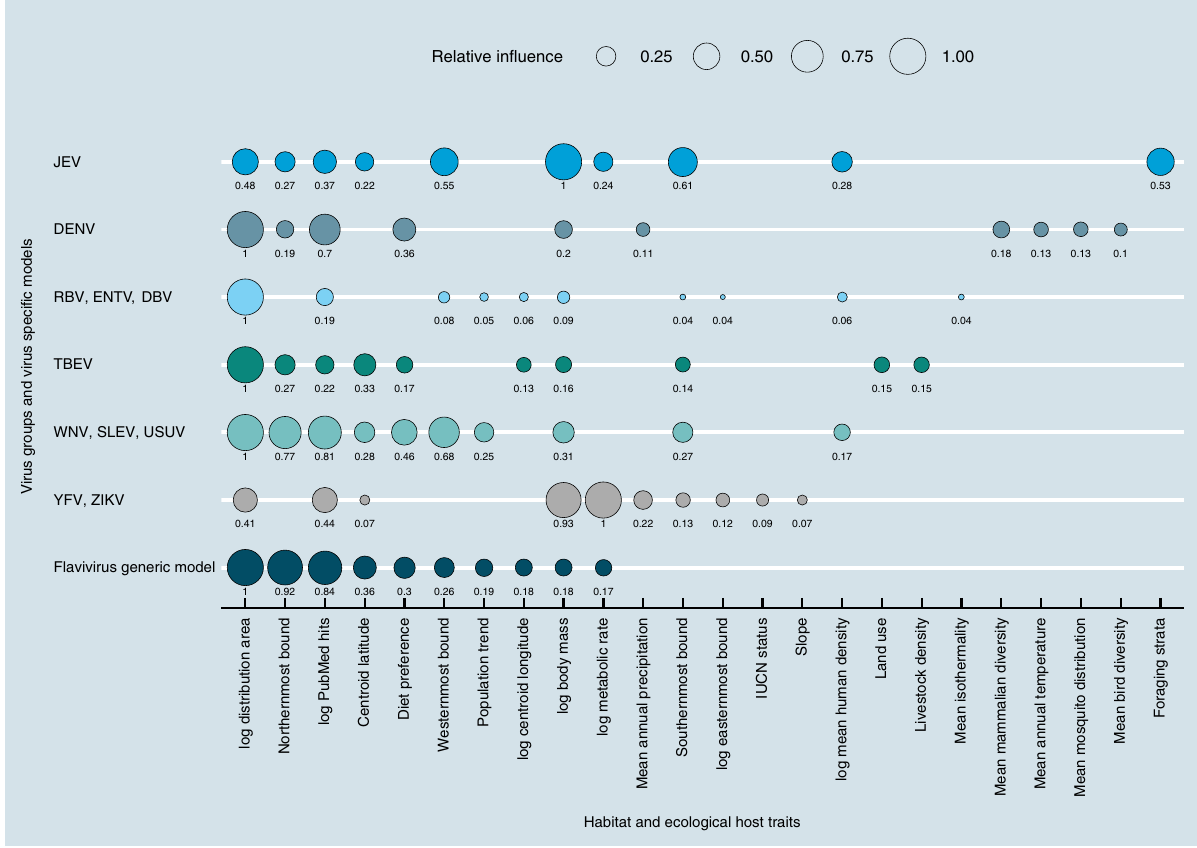
Fig. 2 Macro-ecological traits of fl avivirus hosts. Plot describing the ten most important biological and ecological host traits and their relative in fl uence for all models predicting fl avivirus hosts. YFV, yellow fever virus; ZIKV, Zika virus; WNV, West Nile virus; SLEV, St. Louis encephalitis virus; USUV, Usutu virus; TBEV, Tick-borne encephalitis virus; RBV, Rio Bravo virus; ENTV, Entebbe bat virus; DBV, Dakar bat virus; DENV, dengue virus; JEV, Japanese encephalitis